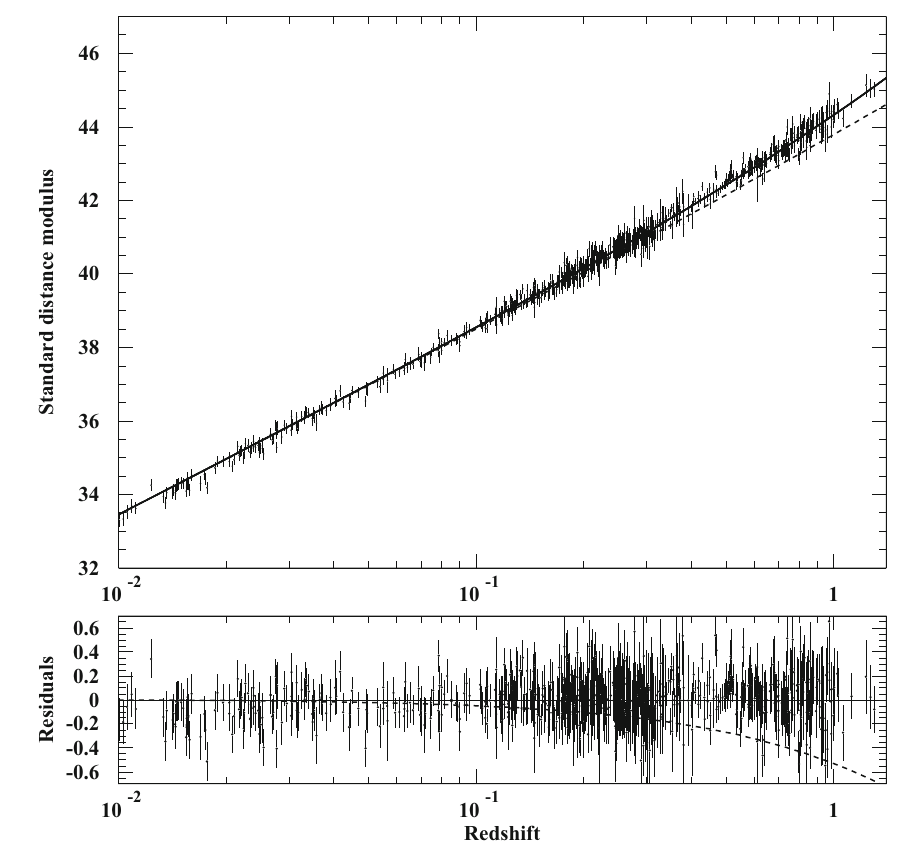
n a s t d i d a r nd a S t